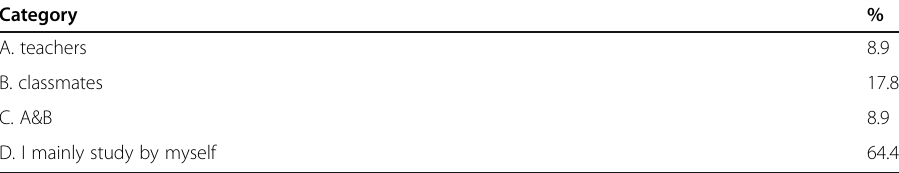
Table 10 Interaction with teachers and classmates